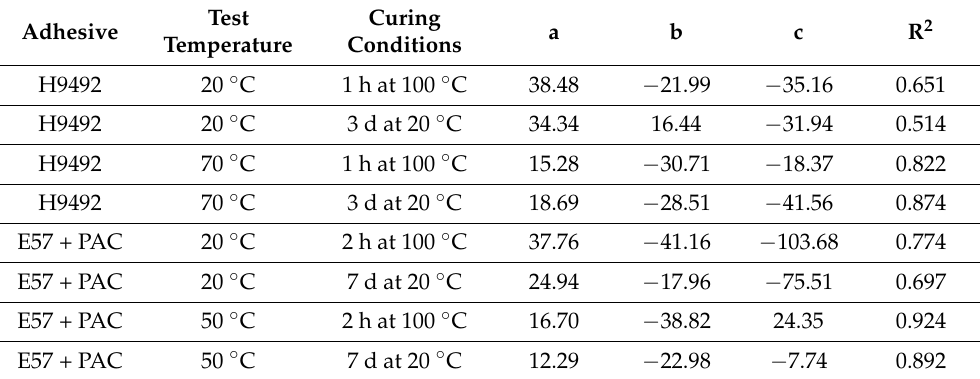
Table 6. Fitting the strength variation curve with respect to the inaccuracy of the adhesive preparation to a second-order polynomial model: strength = a + b · (inaccuracy) + c · (inaccuracy) 2